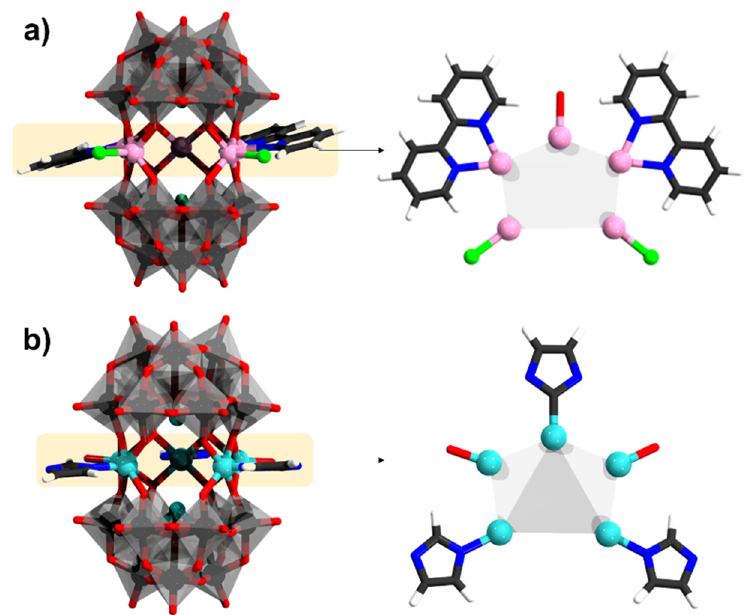
Figure 11. ( a ) [(Mn(bpy)) 2 (MnCl)(Mn(OH 2 )) 2 ( α -SbW 9 O 33 ) 2 ] 8– ; ( b ) {Na 0.7 Ni 5.3 (OH 2 ) 2 (imi) 2 (Himi)( α - SbW 9 O 33 ) 2 }. Color code: Sb = green (but covered), Cl = light green, Mn = pink, Ni = cyan, {WO 6 } = gray octahedra, W = black, and O = red. The partial occupancy of Na + has been omitted.